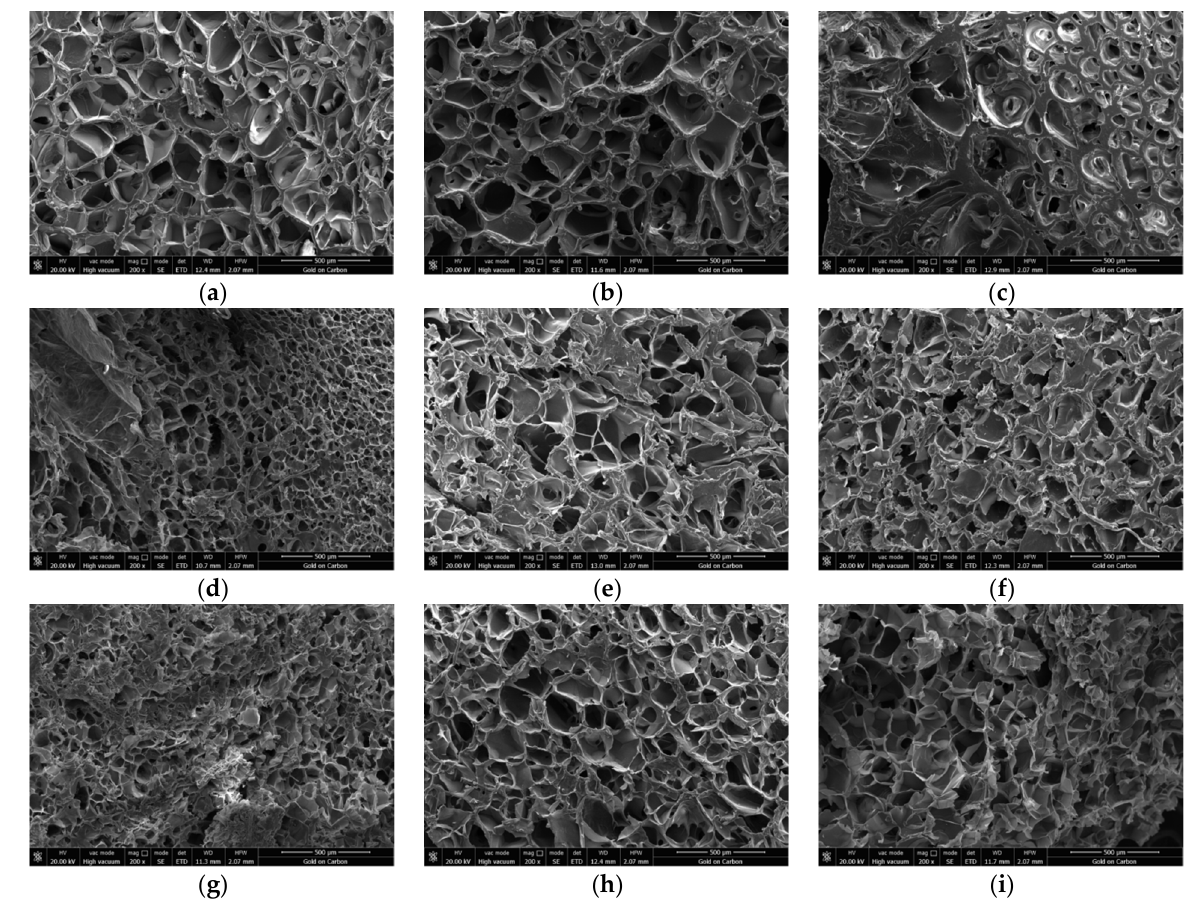
Figure 1. Scanning electron microscopy (SEM) micrographs of the alginate/gelatin/agarose hydrogels. ( a ) Hydrogel composed of 10% gelatin, 2% sodium alginate and 0.2% agarose. ( b ) Hydrogel composed of 15% gelatin, 2% sodium alginate and 0.2% agarose. ( c ) Hydrogel composed of 20% gelatin, 2% sodium alginate and 0.2% agarose. ( d ) Hydrogel composed of 5% gelatin, 0% sodium alginate and 0.2% agarose. ( e ) Hydrogel composed of 5% gelatin, 4% sodium alginate and 0.2% agarose. ( f ) Hydrogel composed of 5% gelatin, 8% sodium alginate and 0.2% agarose. ( g ) Hydrogel composed of 5% gelatin, 2% sodium alginate and 0% agarose. ( h ) Hydrogel composed of 5% gelatin, 2% sodium alginate and 0.4% agarose. ( i ) Hydrogel composed of 5% gelatin, 2% sodium alginate and 0.8% agarose.